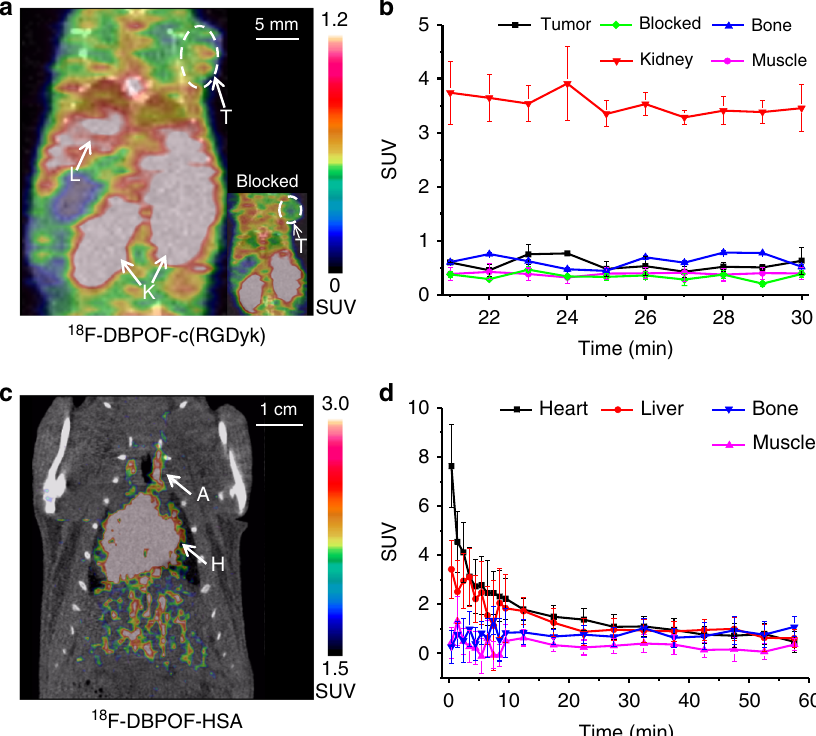
Fig. 3 MicroPET/CT imaging with 18 F-DBPOF-c(RGDyk) and 18 F-DBPOF-HSA. a A PET image from a dynamic scan with 18 F-DBPOF-c(RGDyk) in U87MG nude mice bearing gliomablastoma, reconstructed at 23 min post-injection with the tumor (T), live (L), and kidney (K) indicated by white arrows. The inset image in the right corner showed no speci fi c tumor uptake indicated by a white arrow. b Time-activity curves of 18 F-DBPOF-c(RGDyk) in the tumor, bone, blood, kidney and muscle. Uptake values are presented by means ± standard deviations ( n = 3). c A PET image from a 60 min dynamic scan with 18 F- DBPOF-HAS in healthy female Wistar rats, reconstructed at 60 min post-injection with the heart (H) and artery (A) indicated by white arrows. d Time- activity curves of 18 F-DBPOF-HSA in the heart, liver, bone and muscle. Uptake values are presented by means ± standard deviations ( n = 3). Source data are provided as a Source Data fi